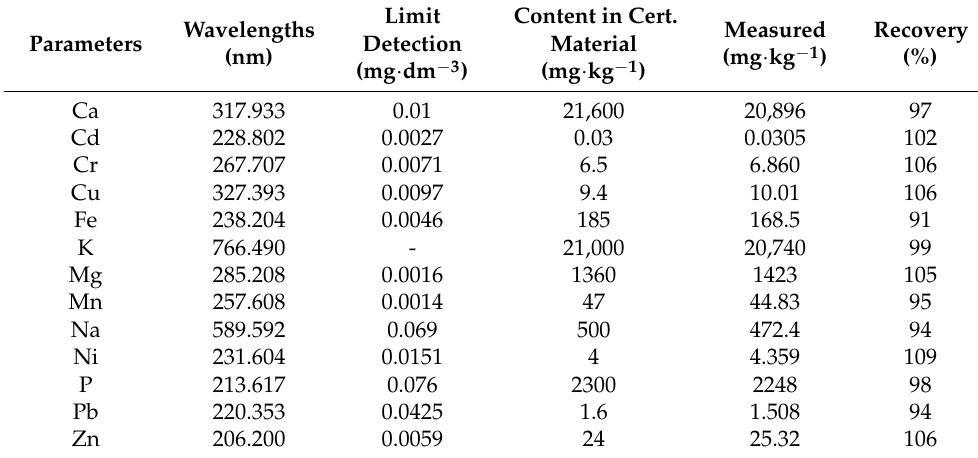
Table 1. Parameters of the analysis